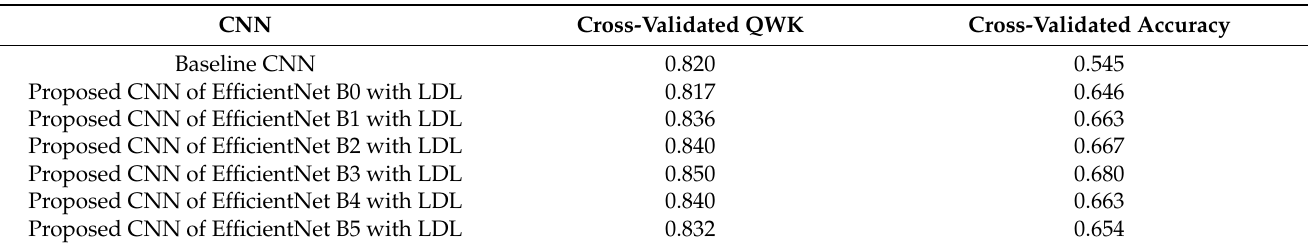
Table 3. Results of the five-fold cross-validation of the baseline and proposed CNNs (EfficientNet